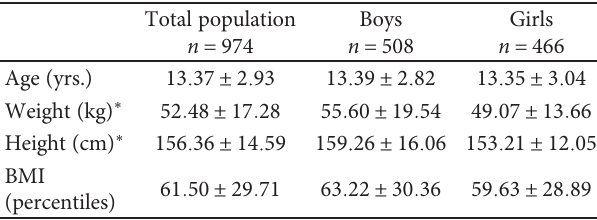
Table 1: Anthropometric characteristics of the population. Data are expressed as mean ±